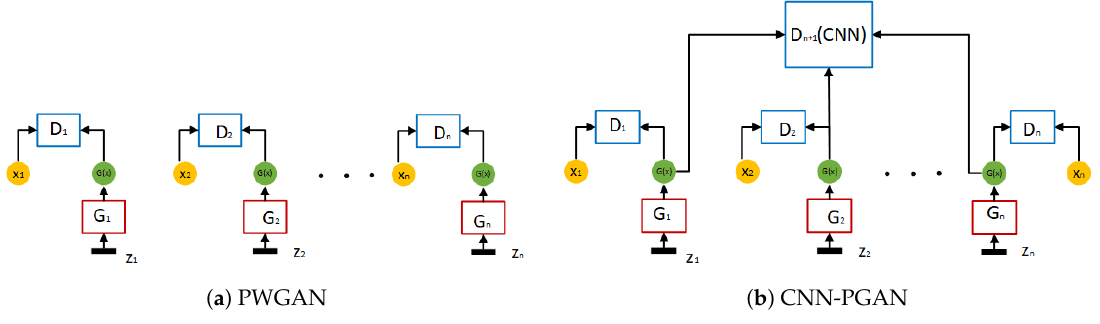
Figure 4. Two different architectures of our proposed